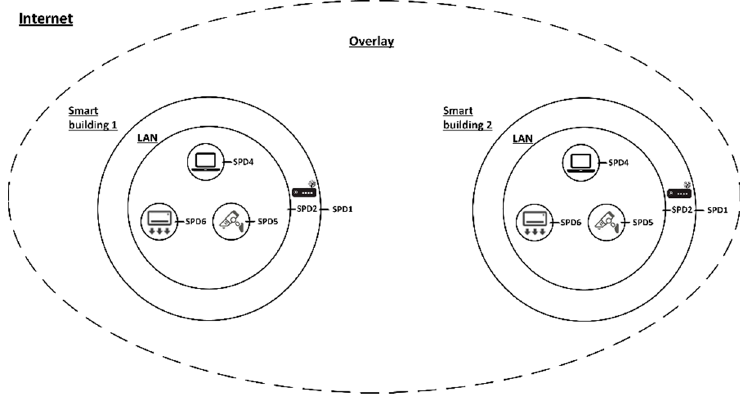
Figure 6. Composition of two smart buildings.